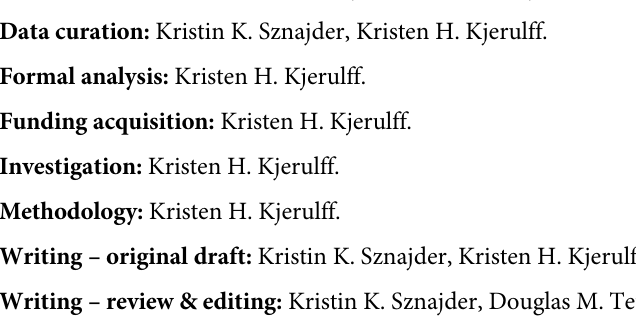
S2 Table. Fully adjusted logistic regression model, dependent variable the Child Behavior Checklist syndrome scale “Anxious/depressed”. S3 Table. Fully adjusted logistic regression model, dependent variable the Child Behavior Checklist syndrome scale “Somatic complaints”. S4 Table. Fully adjusted logistic regression model, dependent variable the Child Behavior Checklist syndrome scale “Withdrawn”. S5 Table. Fully adjusted logistic regression model, dependent variable the Child Behavior Checklist syndrome scale “Sleep problems”. S6 Table. Fully adjusted logistic regression model, dependent variable the Child Behavior Checklist syndrome scale “Attention problems”. S7 Table. Fully adjusted logistic regression model, dependent variable the Child Behavior Checklist syndrome scale “Aggressive